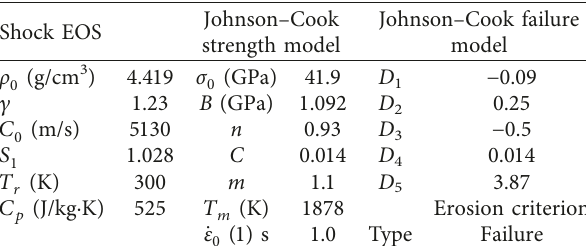
Table 3: Material parameters of